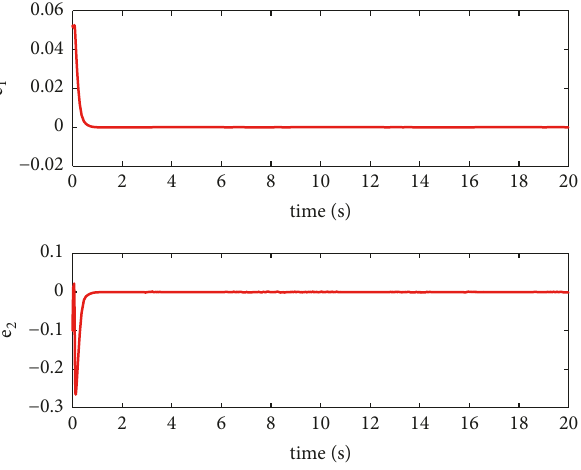
Figure 8: The control input of NNSMC.